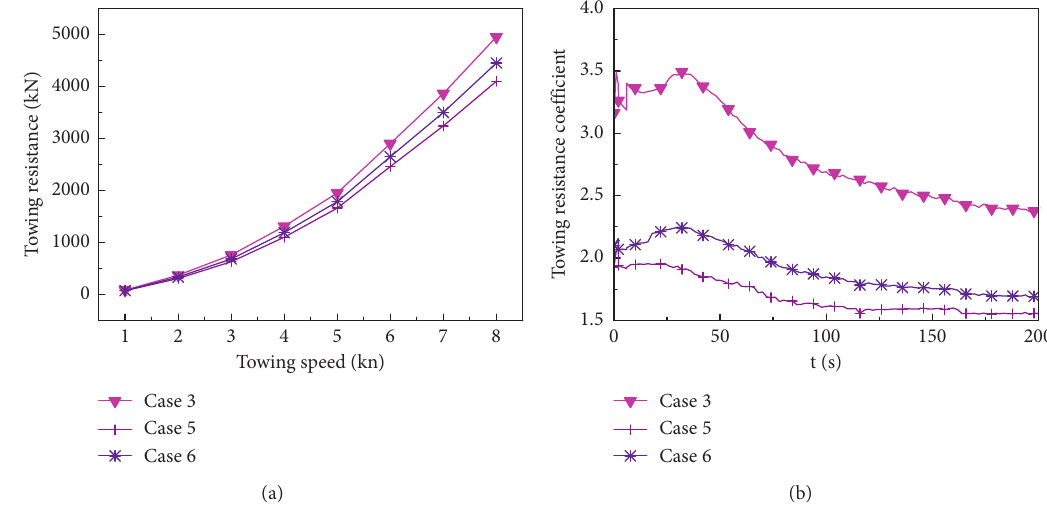
Figure 14: (a) The towing resistance of the platform at different towing speeds. (b) The towing resistance coefficient of the braces in Cases 3, 5, and 6 at the towing speed of